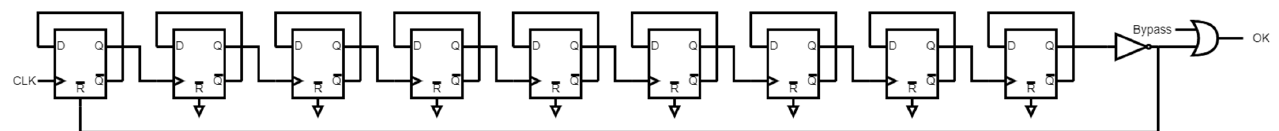
Figure 6. Simple all digital OK circuit.